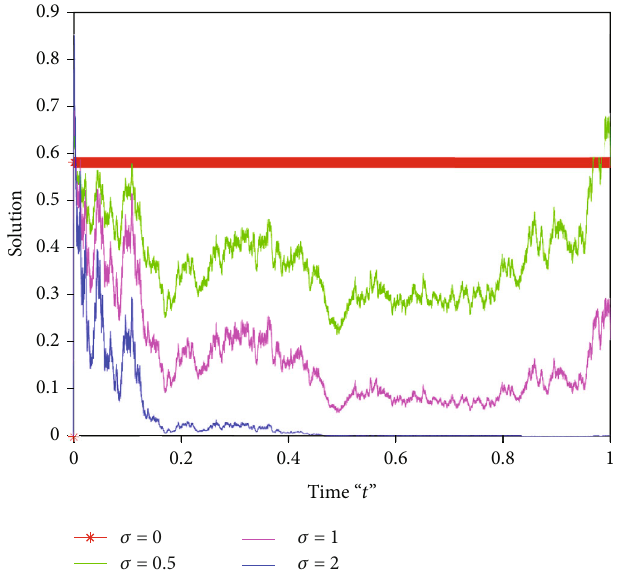
Figure 5: 2D graph of Equation